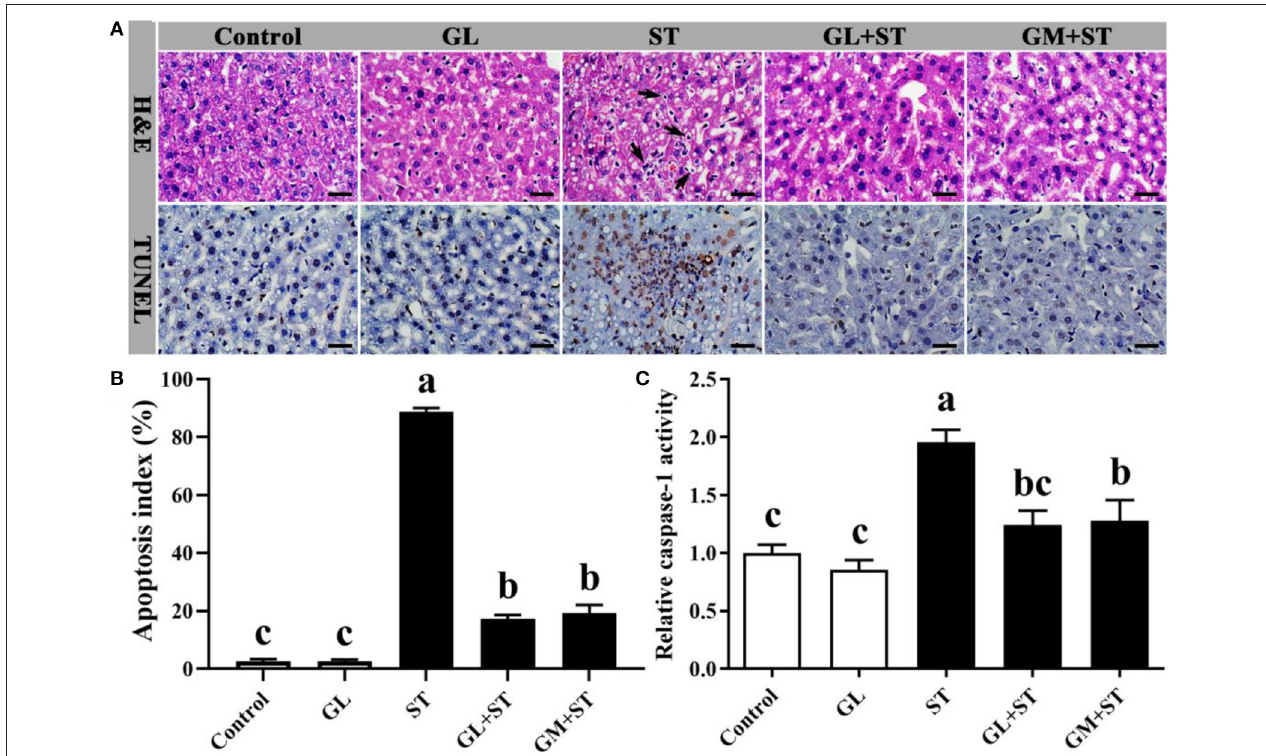
FIGURE 3 | Effect of GL on liver morphology and hepatocytic apoptosis in ST-infected mice. (A) H&E staining and TUNEL assay (scale bar, 50 µ m). H&E: Black arrow indicates apoptotic cells. TUNEL assay: Apoptotic cells were labeled as brown, and intact cells were labeled as blue. (B) Apoptosis index was calculated according to the formula: Apoptosis index (%) = [the number of apoptotic cells/(the number of apoptotic cells + the number of intact cells)] × 100. (C) Caspase-1 activity in liver was determined by caspase-1 activity assay kit. Results are presented as mean ± SD ( n = 5/group). Different lowercase letters indicate a significant difference ( P <